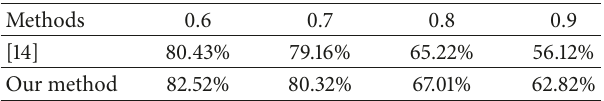
Table 1: Results on the KITTI and Karlsruhe dataset for different IoU